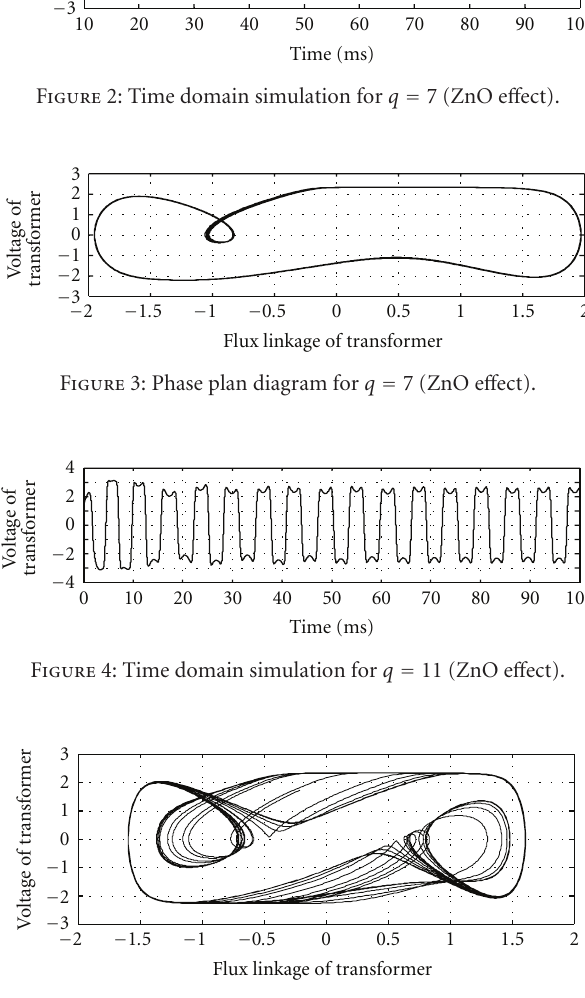
Figure 5: Phase plan diagram for q = 11 (ZnO e ff